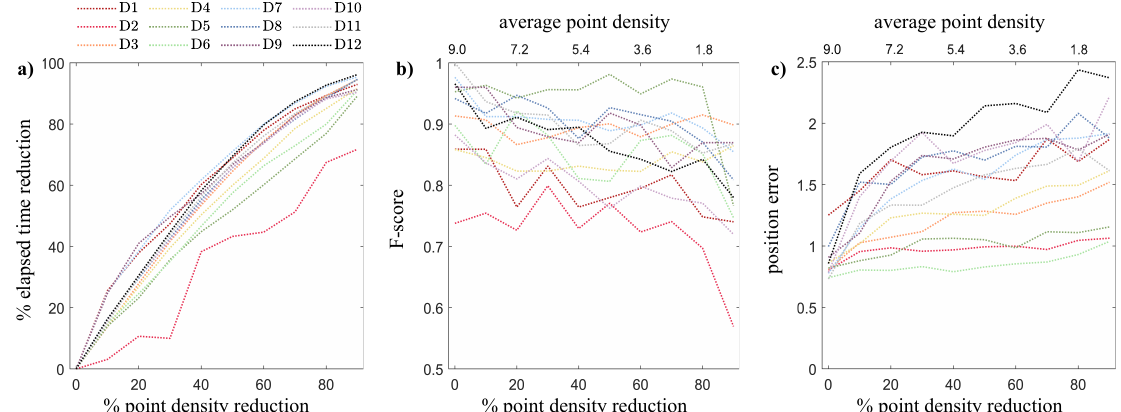
Figure 10. ( a ) Percentage time reduction, ( b ) F-score, and ( c ) position error at different re-sampling rates for considered twelve study